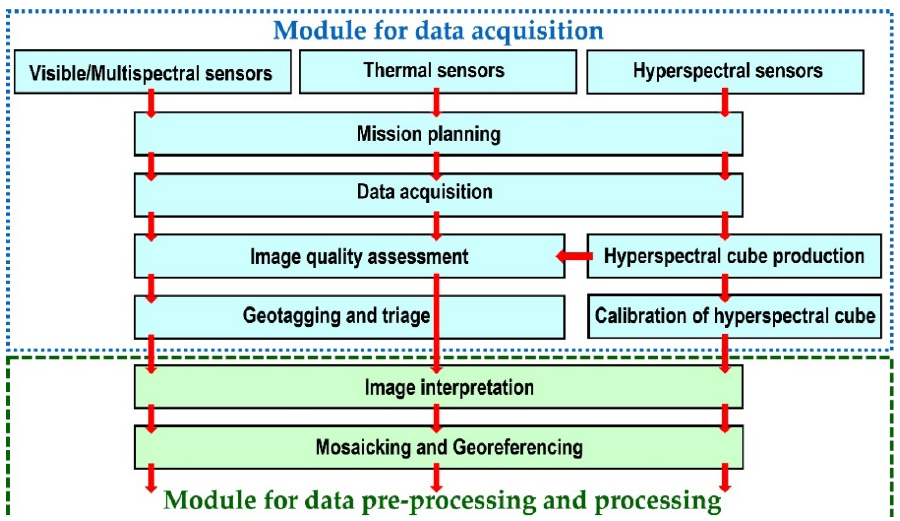
Figure 4. The main steps within module for data acquisition.